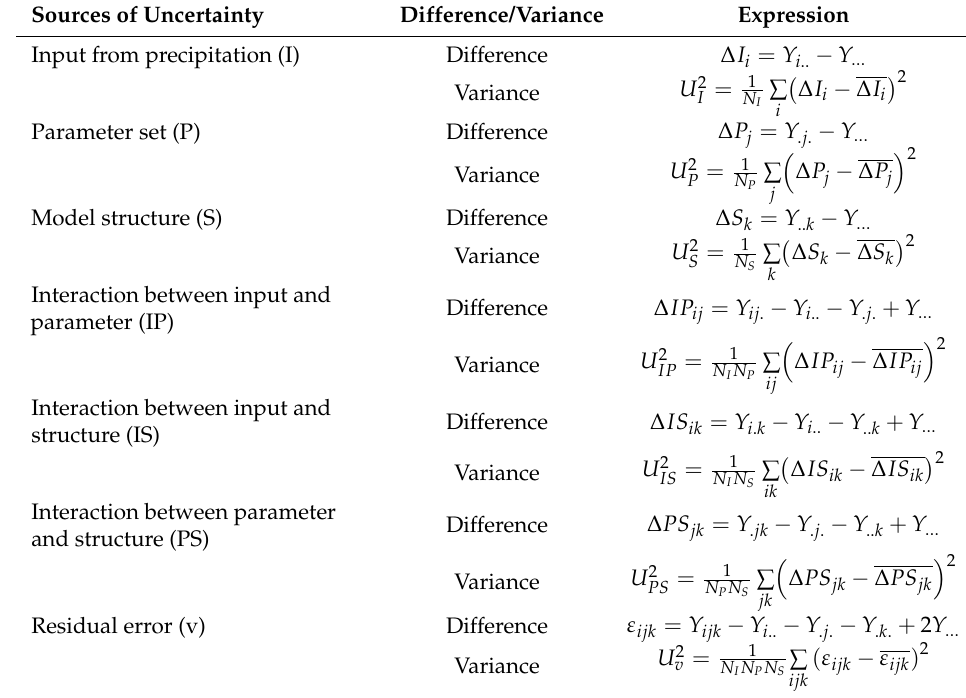
Table 2. Decomposition of total uncertainty into seven components using the variance decomposition